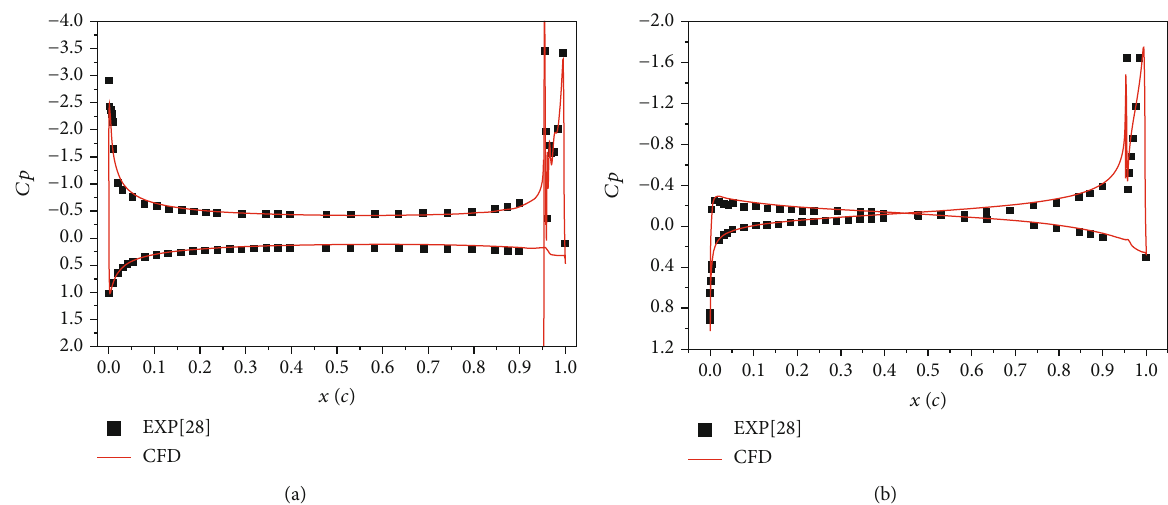
Figure 6: Comparison of pressure coe ffi cient at the model mid-span section for CC validation: (a) upper slot blowing; (b) lower slot blowing.